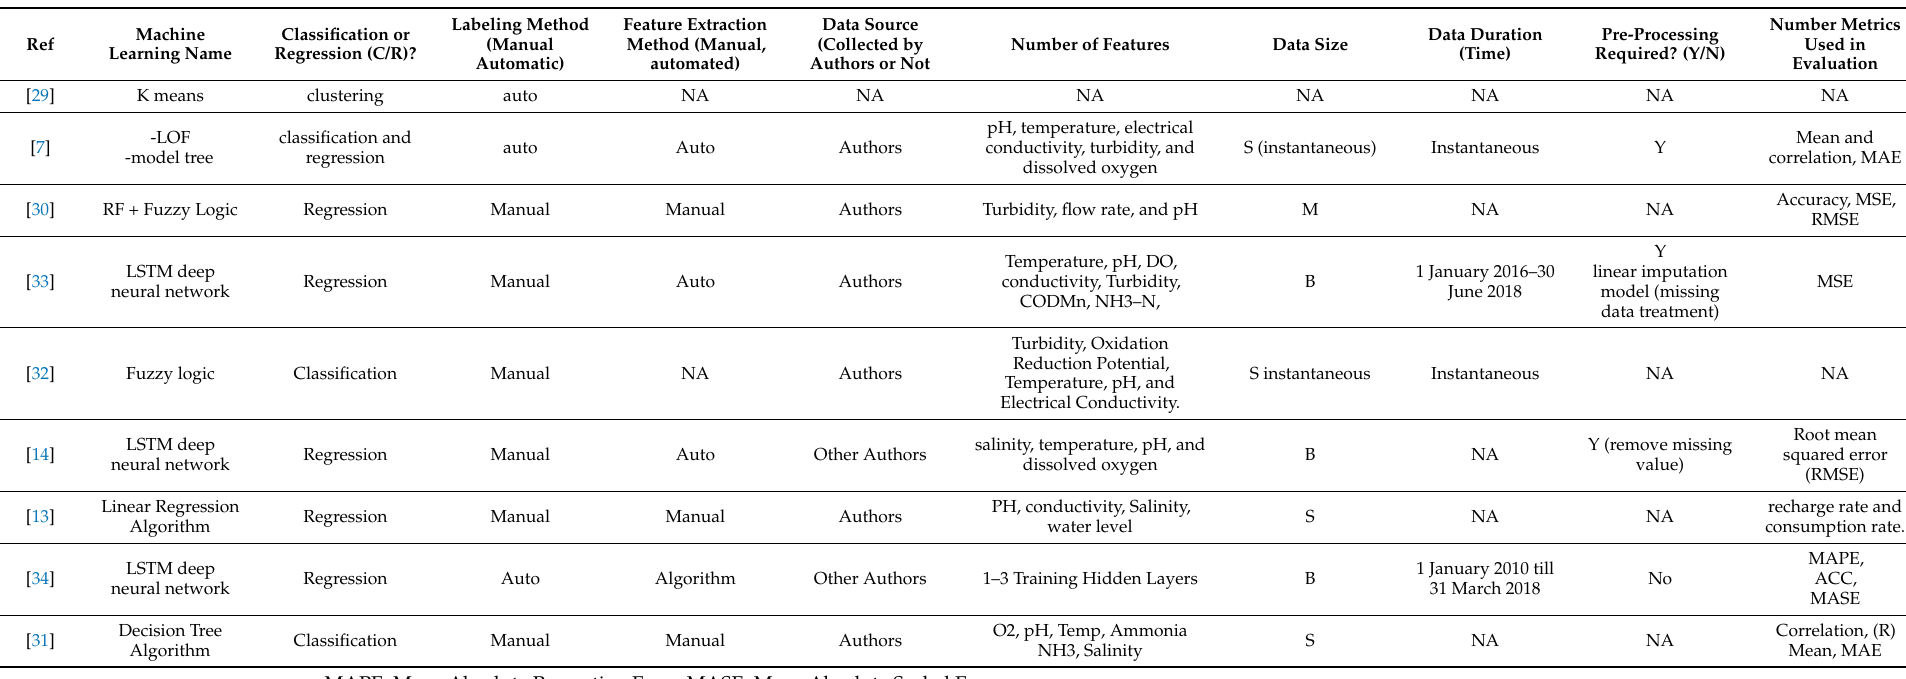
Table 2. AI Experimental Analysis.